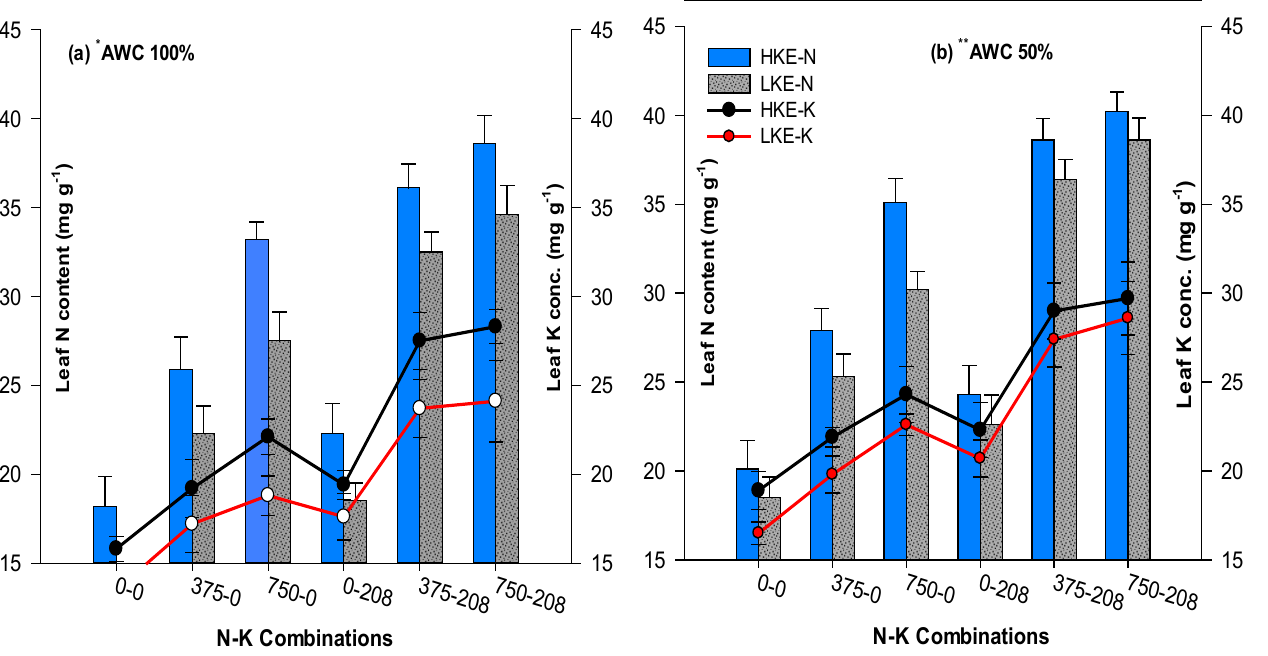
Figure 3. Interactive effects of N:K levels on leaf N and K contents in HKE and LKE cultivars of cotton at AWC 100% ( a ) and AWC 50% ( b ) irrigation levels. * ANOVA significant at p < 0.05; ** ANOVA significant at p < 0.01. Error bars are showing the standard error of mean.